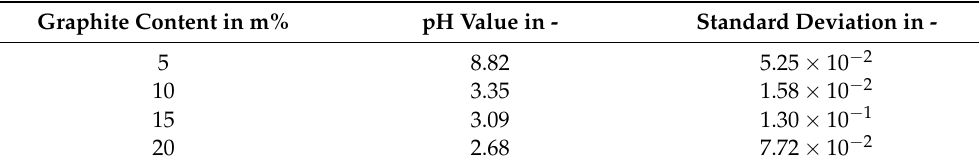
Table A10. PH values as a function of graphite content for a solution with 40 m% TX-100. Graphite Content in m% pH Value in